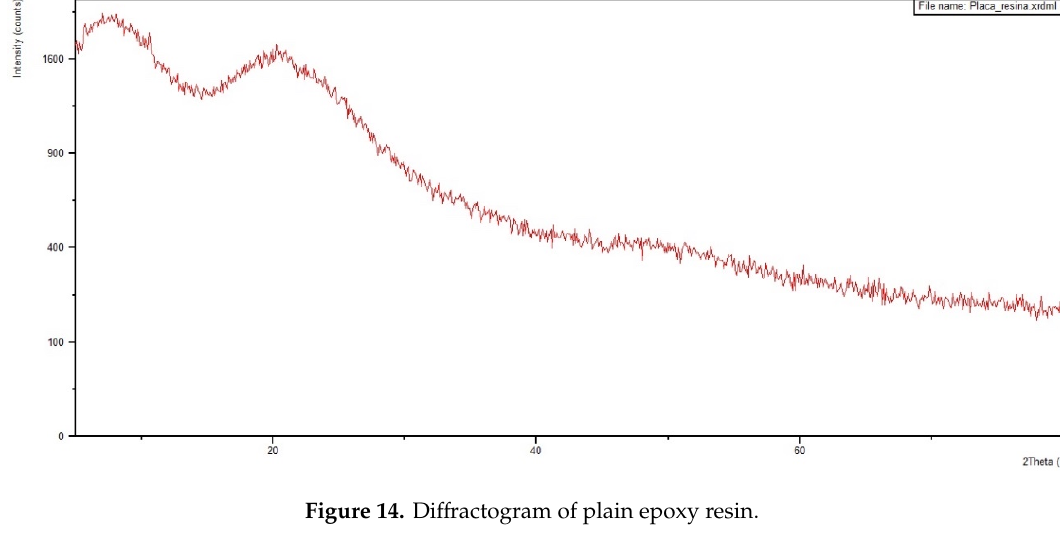
Figure 13. Diffractogram of the 30 vol% ramie fabric-reinforced GO-incorporated epoxy composite in the physical state of a solid plate.